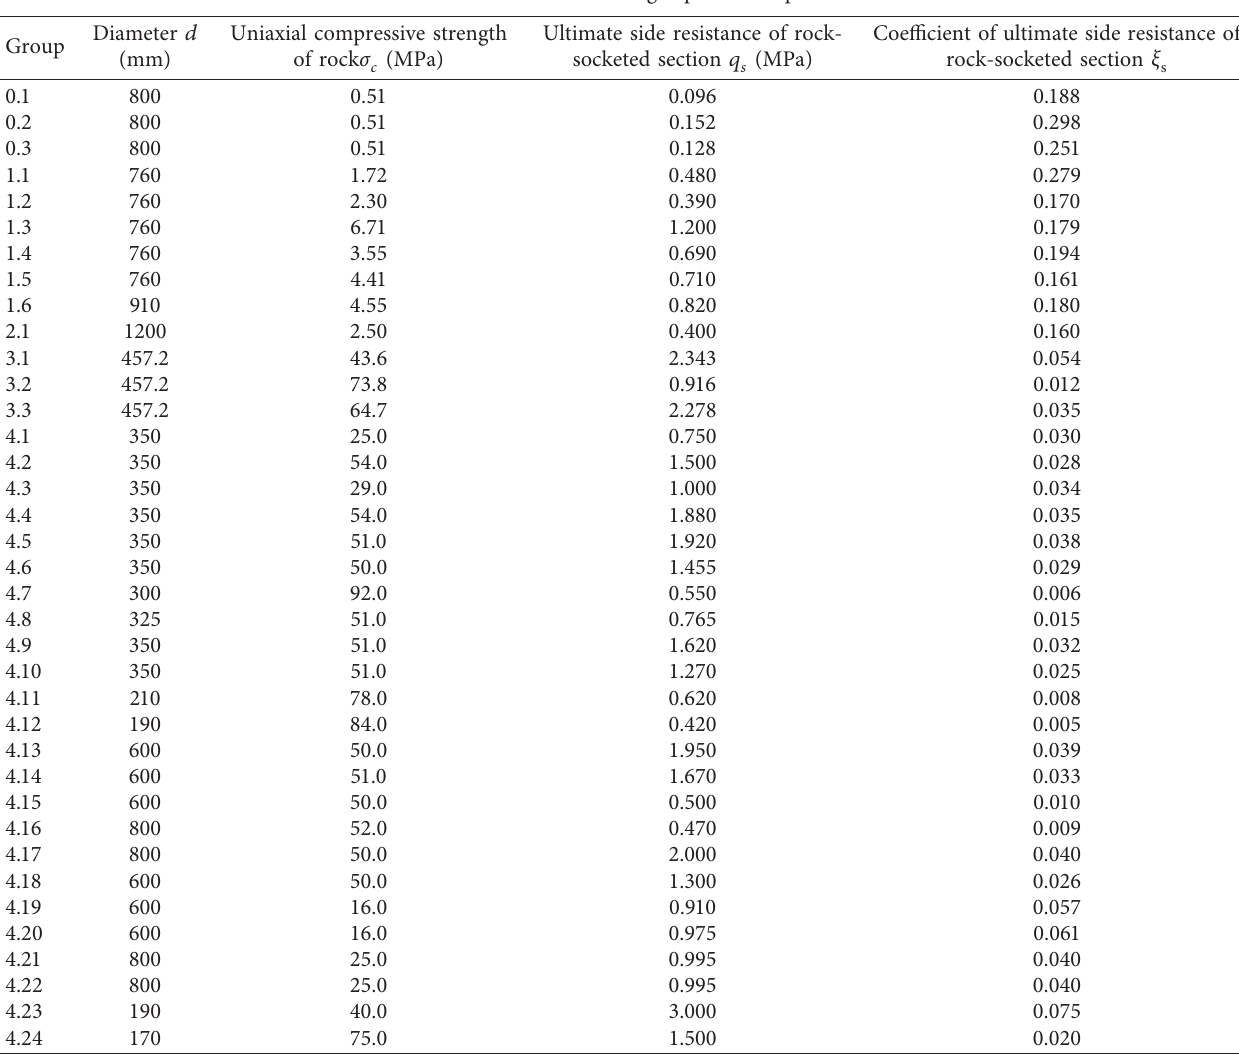
Table 7: Data from load tests of side-bearing capacities of piles socketed into